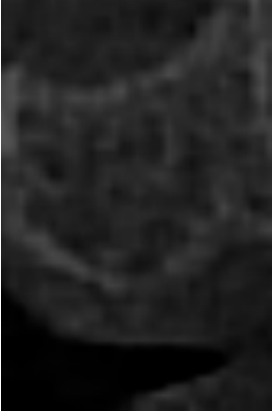
Figure 2. I—the impacted teeth.